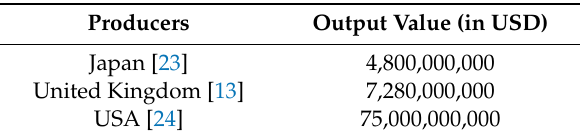
Table 1. Total output value of remanufacturing in Table 1 . Total output value of remanufacturing in 2016.